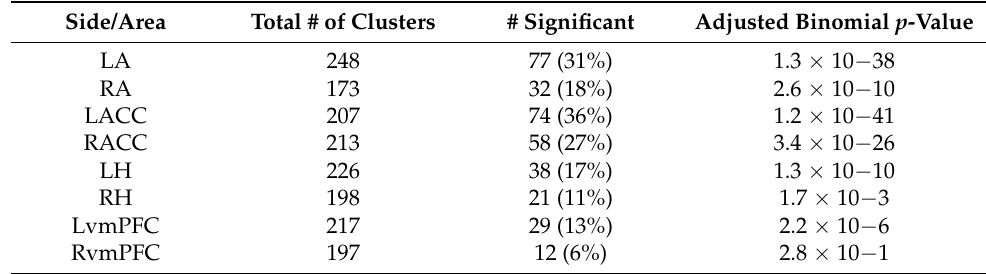
Table A6. Reliable cluster responses (MUA) by side and brain area across all patients ( n = 13), as indicated by the change from background